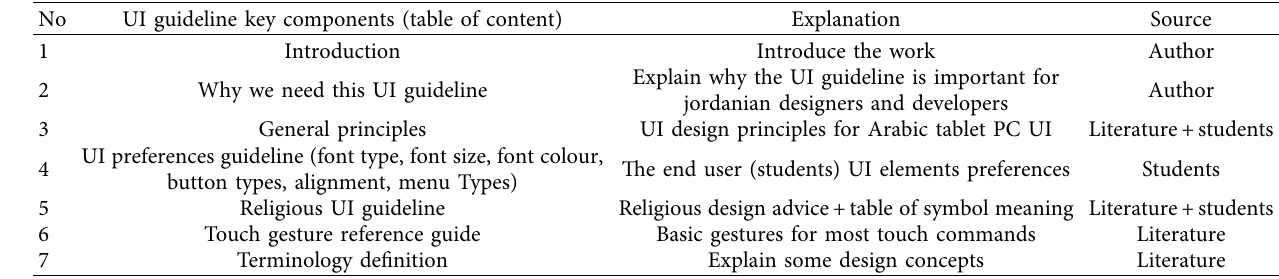
Figure 3: Satisfaction scores of experts during round two of the Delphi study. Table 4: The fina version of the Arabic UI